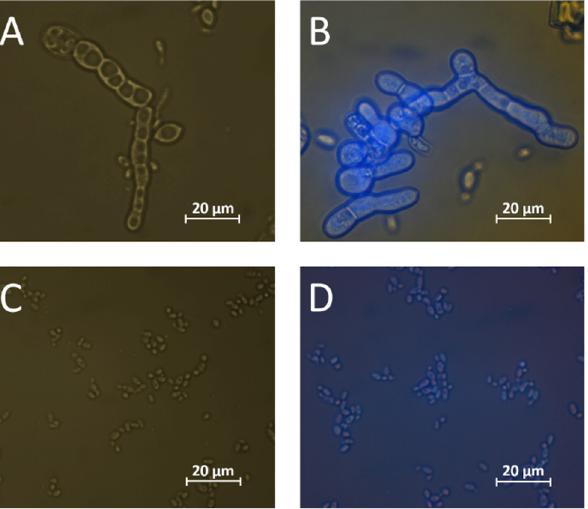
Figure 6. Visualization of 4-MU localization before (left) and after (right) the incubation of yeast cultures with 4-MUG. A. pullulans ( A , B ) and I. terricola ( C , D ) cultures were incubated with 4-MUG and analyzed via fluorescence microscopy as described in the material and methods section. The exposure time was identical for all pictures.